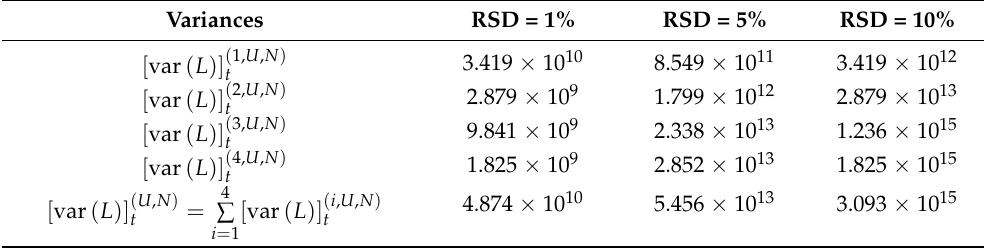
Table 2. Comparison of Variances for Various Relative Standard Deviations (RSD) of the Normally- Distributed and Uncorrelated Microscopic Total Cross